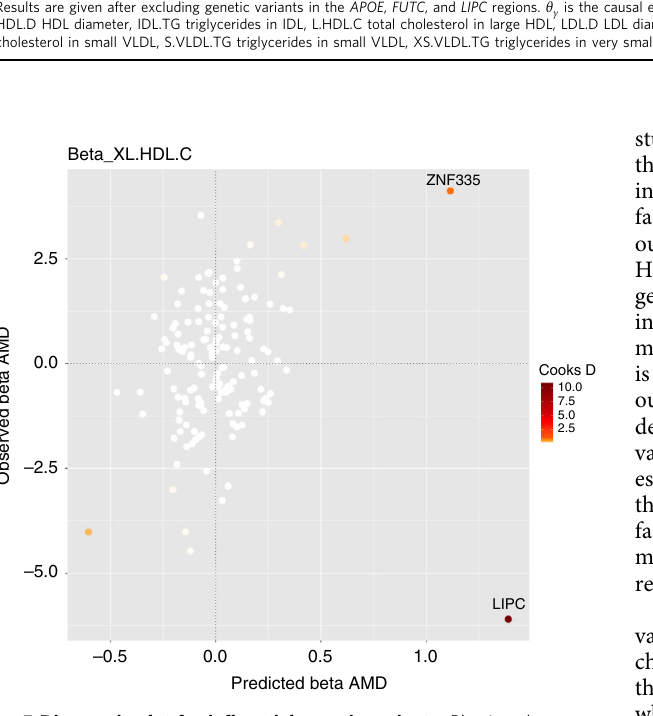
Fig. 5 Diagnostic plot for in fl uential genetic variants. Plotting the predicted associations with AMD based on the model including XL.HDL.C ( x -axis) against the observed associations with AMD ( y -axis) showing all n ¼ 148 genetic variants, where the colour code shows Cook's distance for the genetic variants. This is the highest-ranking model on omission of outlying and in fl uential genetic variants from the analysis. Note rs26134 in the LIPC gene region which has an anomalous direction of association with AMD risk in contrast to all other genetic